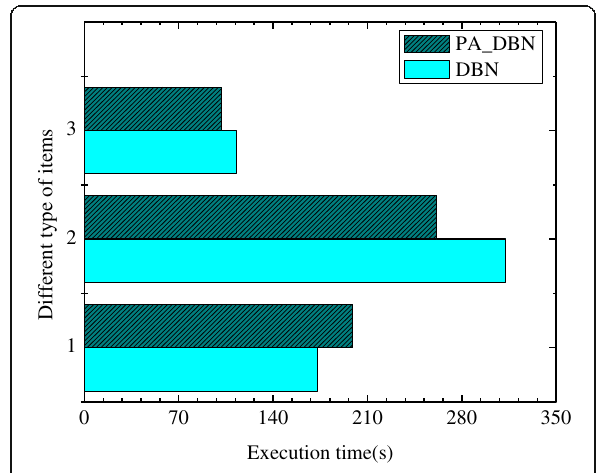
Fig. 3 The comparison with the two algorithms